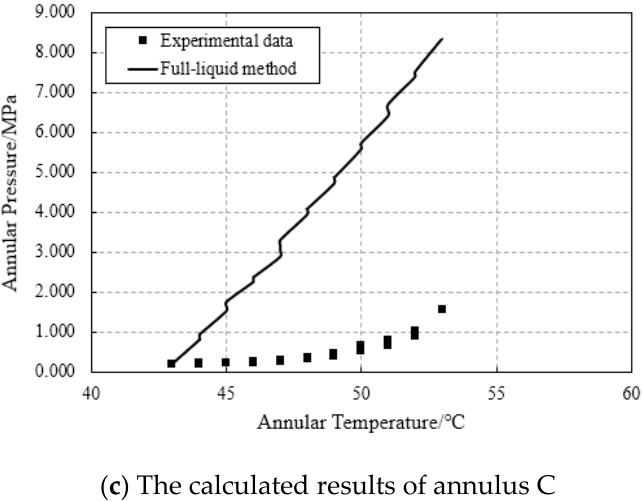
Table 4. The error analysis of simulations using the full-liquid model.